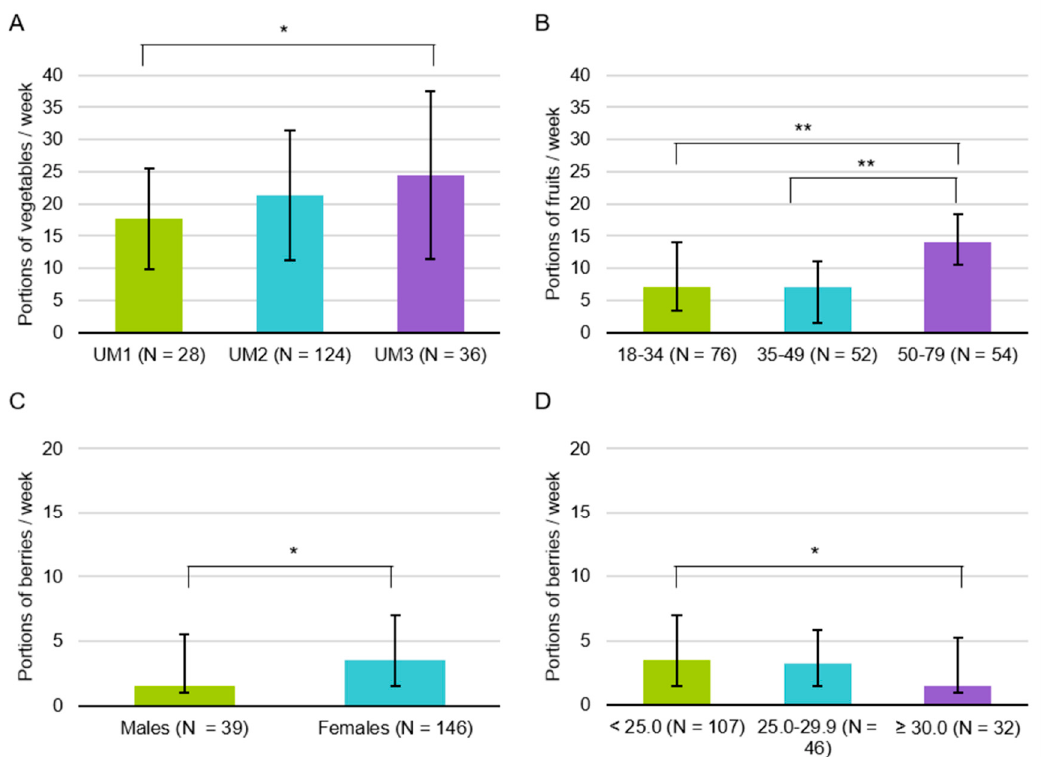
Figure 1. The significant group differences in the number of portions of vegetables (mean and standard deviation), fruits, and berries (median and interquartile range) per week (possible range 0-42). ( A ) vegetable portions by umami sensitivity groups, UM1 = the least sensitive, UM2 = the semi-sensitive, UM3 = the most sensitive, ( B ) fruit portions by age groups (years), ( C ) berry portions by sex, ( D ) berry portions by BMI groups. * p < 0.05, ** p < 0.001 based on the Tukey ( A ) and Mann-Whitney U ( B - D ) test. The more common habit of adding milk to co ff ee was related to female sex, younger age, higher education (U = 1075.5, p < 0.001, H (2) = 12.7, p = 0.002, and U = 2434.5, p = 0.048,